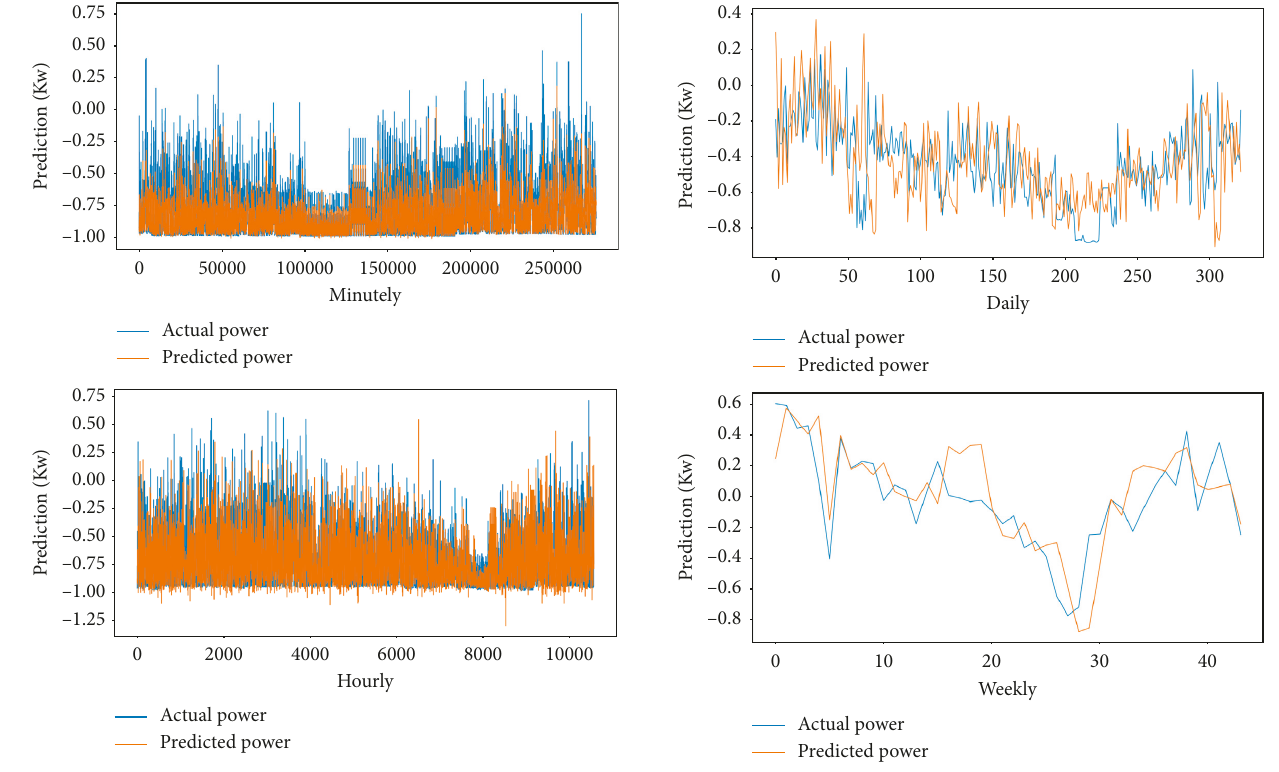
Figure 6: Visual representation of GRU-based forecasting results considering daily and weekly horizons on the household power